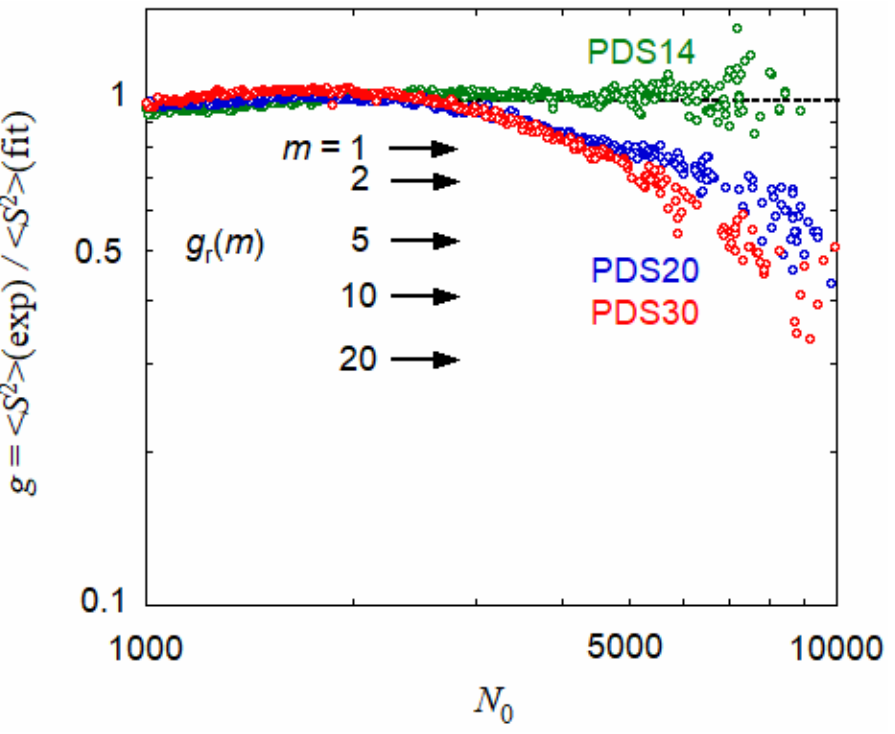
Figure 6. Ratio g of the experimental mean square radius of gyration for three PUL-OSA samples to the theoretical calculated by Equation (11) with the parameters mentioned in the caption of Figure 3 (cf. solid curves in Figure 3). Arrows indicate theoretical g -factors for the branched polymer of the random-type, calculated by Equation (13) for f = 4 and different m . In Figure 4, SAXS profiles in the low k region were fitted by Equation (10) for fractal aggregates. However, this equation is a just phenomenological equation, not specifying any concrete structure of the aggregate. Furthermore, the weight fraction w agg of the aggregating component of PUL-OSA is so small (cf. Table 3b) that the characterization of the aggregating component is not easy. The suggestion of the branched loose flower necklace for the aggregating component of PUL-OSA with higher DS by SEC-MALS has not been supported by other experimental evidence at present. Kurata and Fukatsu [23] calculated the g -factor for the branched polymer of the random-type branching with m branch points of the functionality f and p Gaussian sub- chains of random distribution of the degree of polymerization. Their result is given by